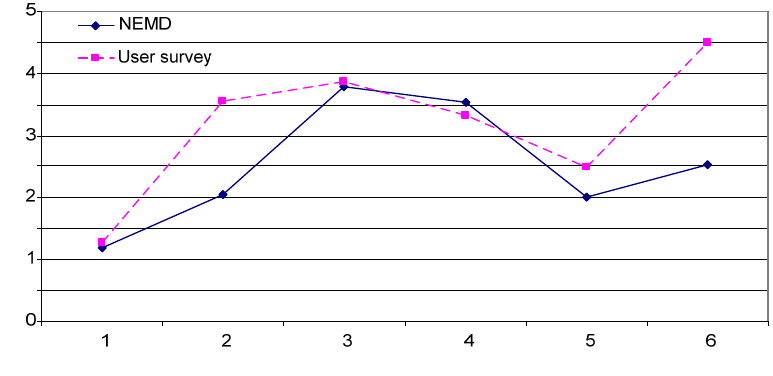
Figure 6. Correlations between NEMD and user survey.